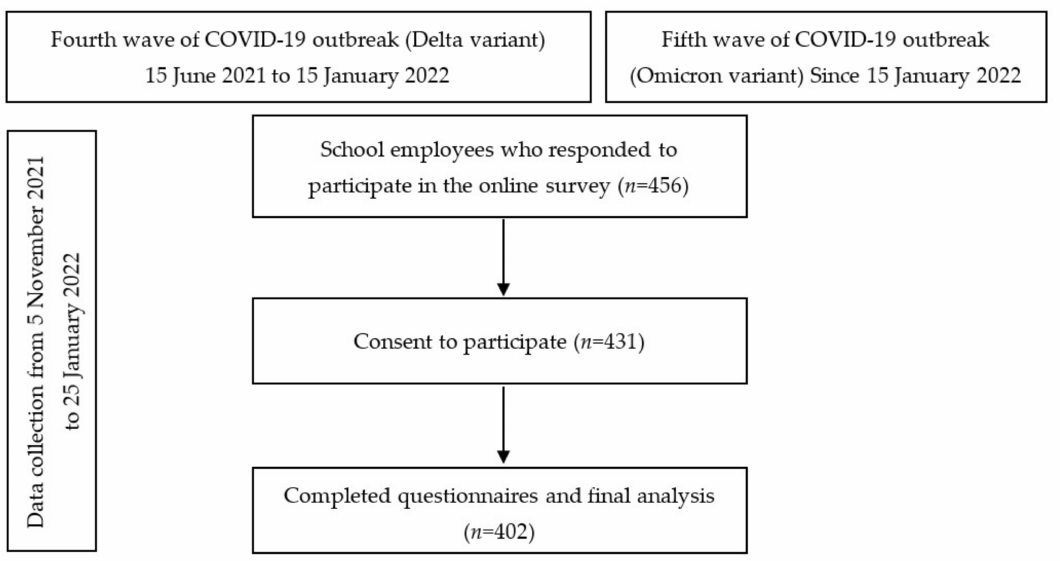
Figure 1. The study flow diagram and pandemic